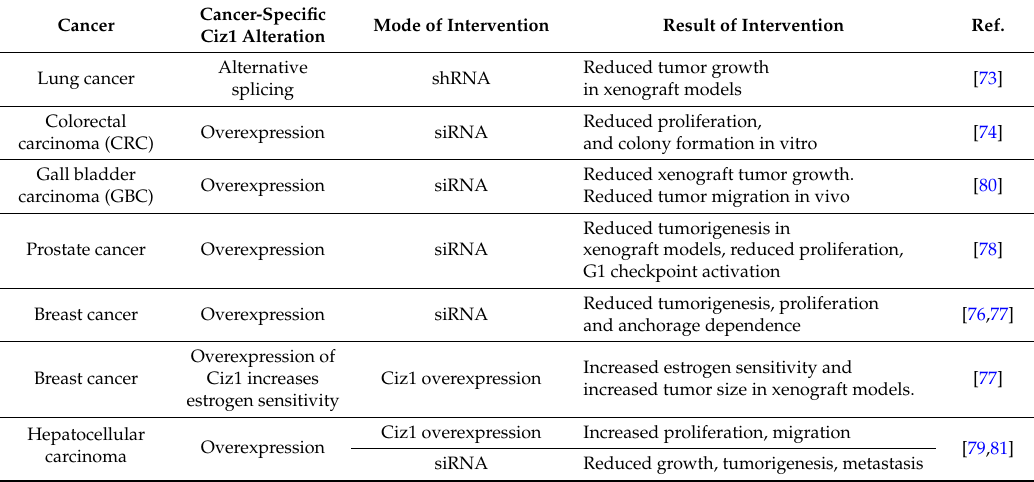
Table 1. Ciz1 is associated with tumor growth in multiple cancers. A summary of evidence is presented showing the effect of Ciz1 overexpression or depletion of Ciz1. Results from overexpression or depletion and consequences for tumorigenicity are